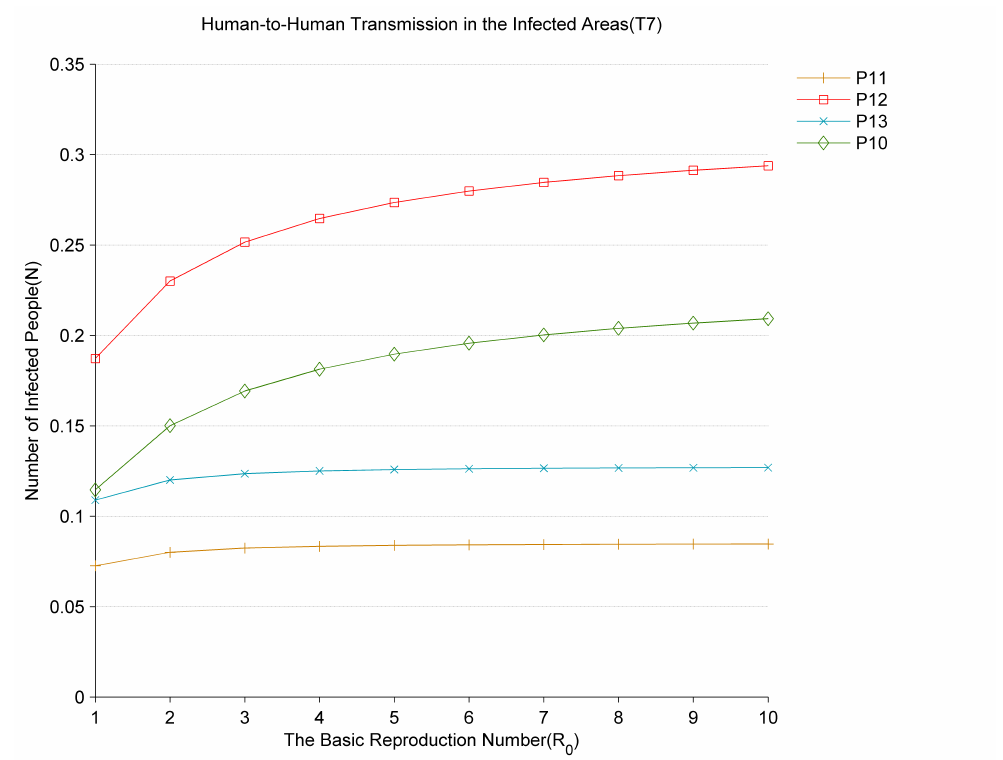
Figure 6. Relationship between the basic reproduction number ( R 0 ) and the number of infected people in the infected